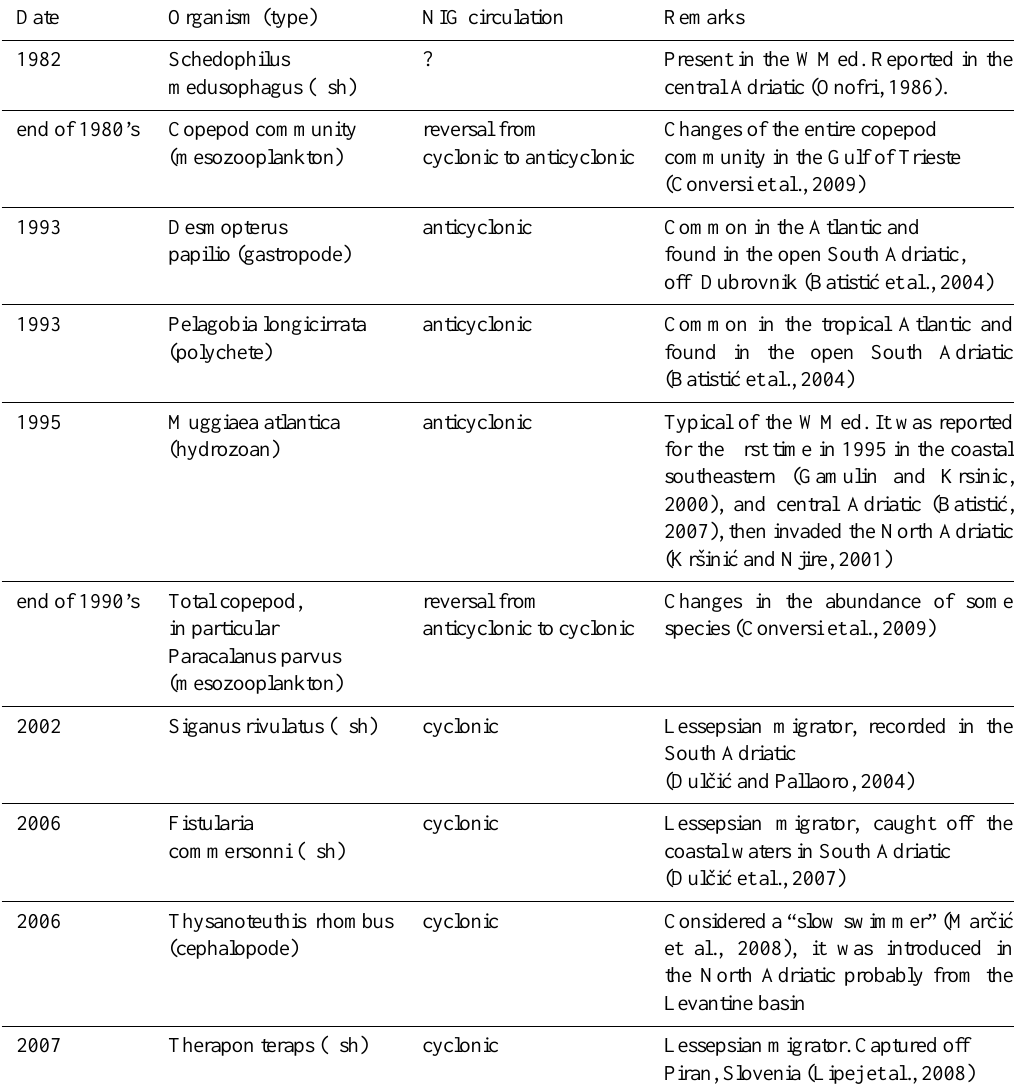
Table 2. Biological records and changes in NIG